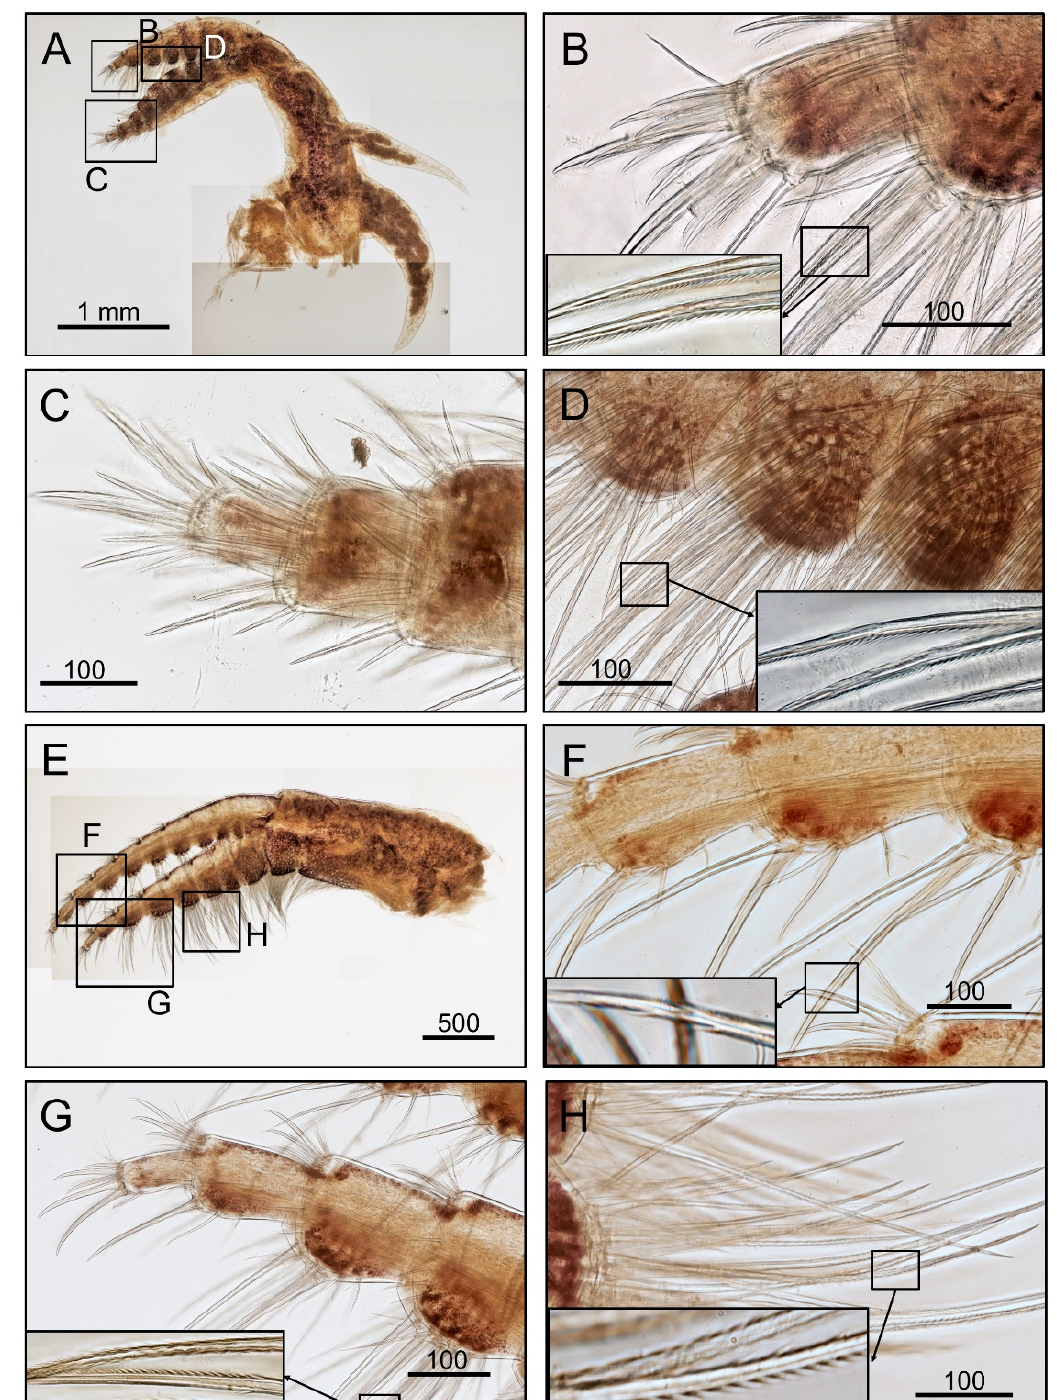
Figure 2. Conchoderma virgatum . ( A ) Cirrus I, showing two filamentary appendages at base region. ( B ) Posterior ramus, showing serrulate setae. ( C ) Anterior ramus, showing serrulate setae. ( D ) Protuberant segment of cirrus I, showing serrulate setae. ( E ) Cirrus II. ( F ) Posterior ramus showing serrulate setae. ( G ) Anterior ramus, showing serrulate setae. ( H ) Intermediate segment of anterior ramus, showing serrulate setae. Scale bars in μ m.